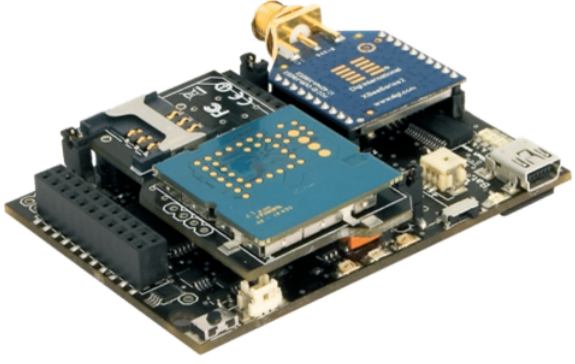
Figure 7. Waspmote node main board with attached XBee